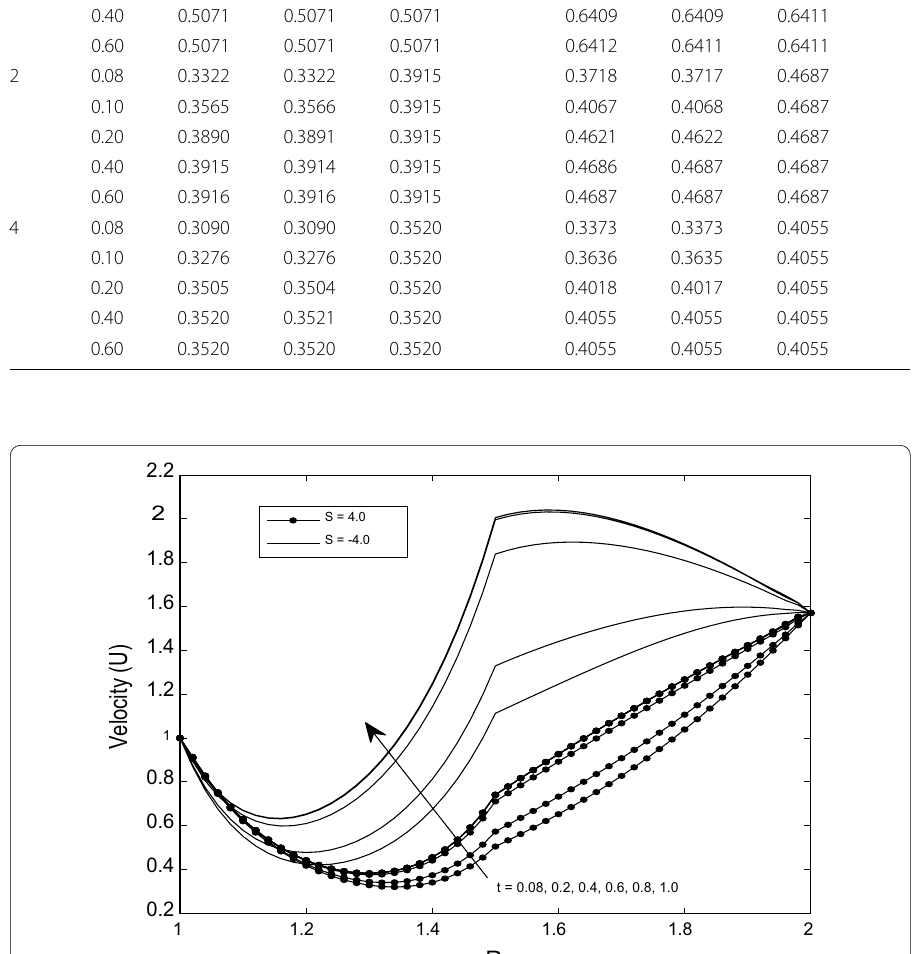
10, β 0.2, d 1.5,Da 0.02, A ∗ = = − = =